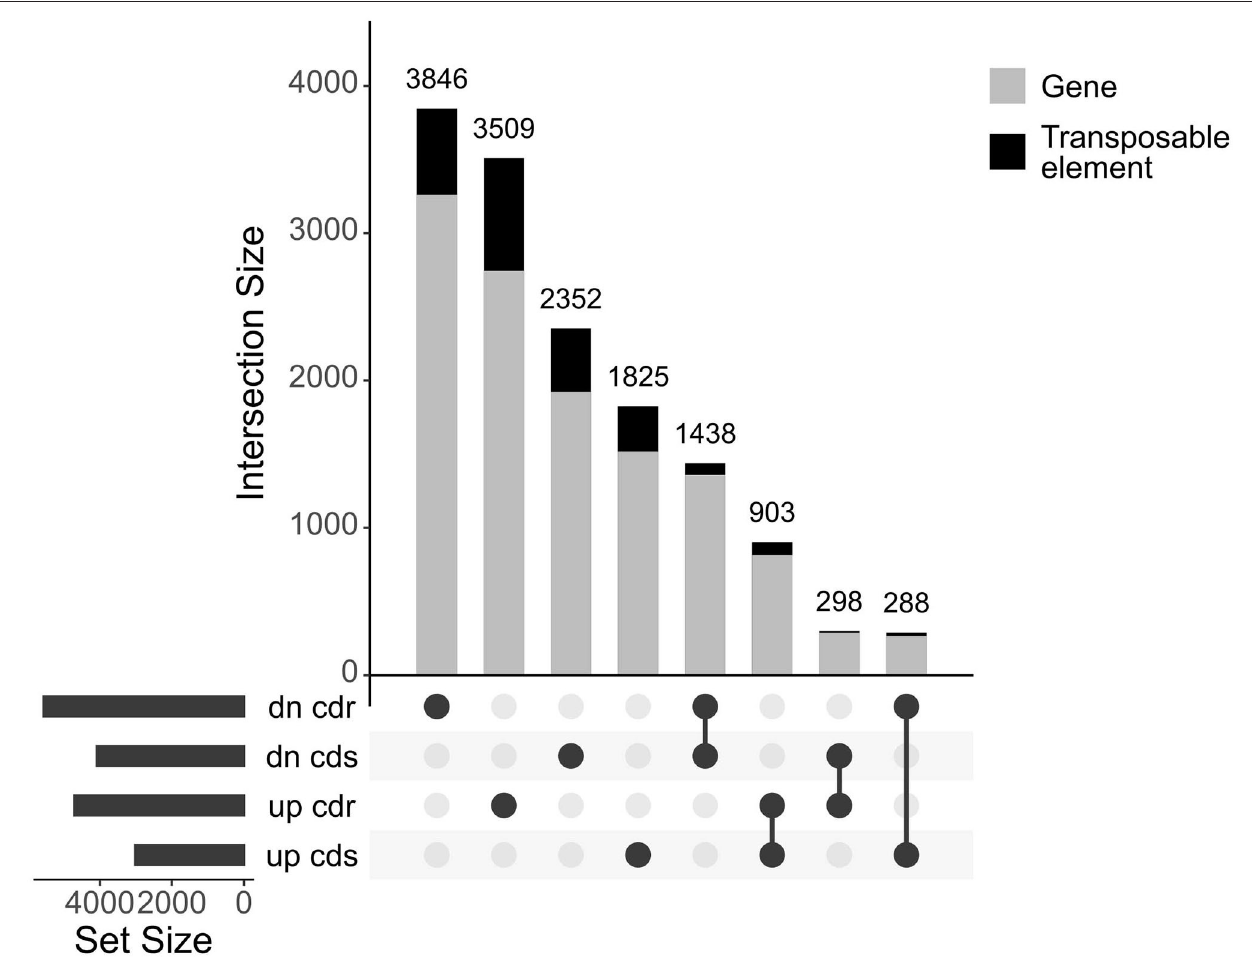
FIGURE 4 | UpSet plot of the differentially expressed transcripts under cadmium treatment comparing response in root and shoot. Transcripts with a p -value below 0.05 were retained. Count of transcripts are displayed over the bars for each relationship of up and down (dn)-regulated transcripts from both root (cdr) and shoot (cds). The bars are colored according to the proportion of transcripts coming from both genes and transposable elements in gray and black,